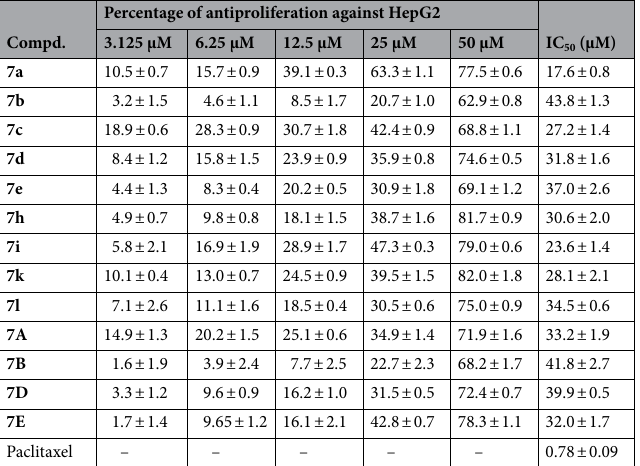
Percentage of antiproliferation against Compd.